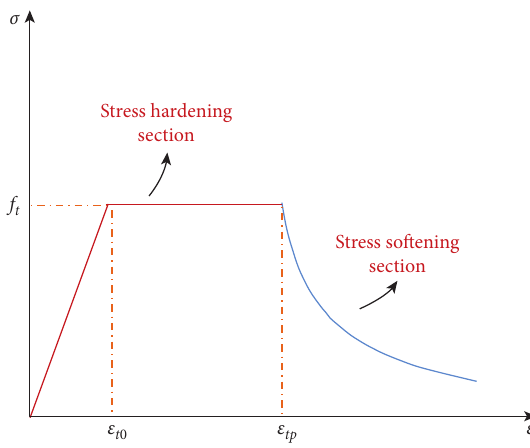
Figure 6: Uniaxial tensile constitutive model of UHPC.